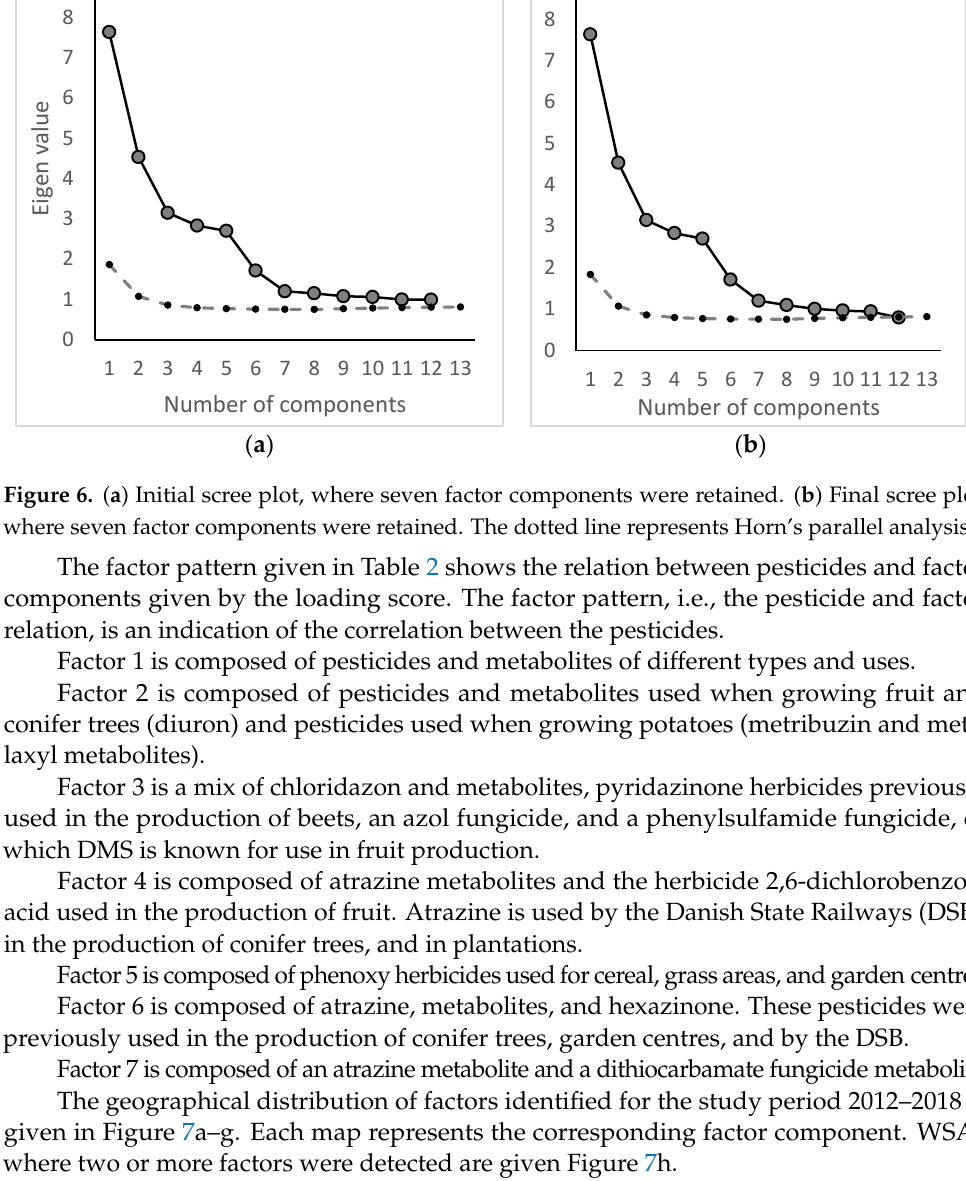
Table 2. Resulting factor pattern for the factor analysis 2012 – 2018. Loading scores are marked in bold if they meet the criterion of a loading score >0.45 or < −0 .45.